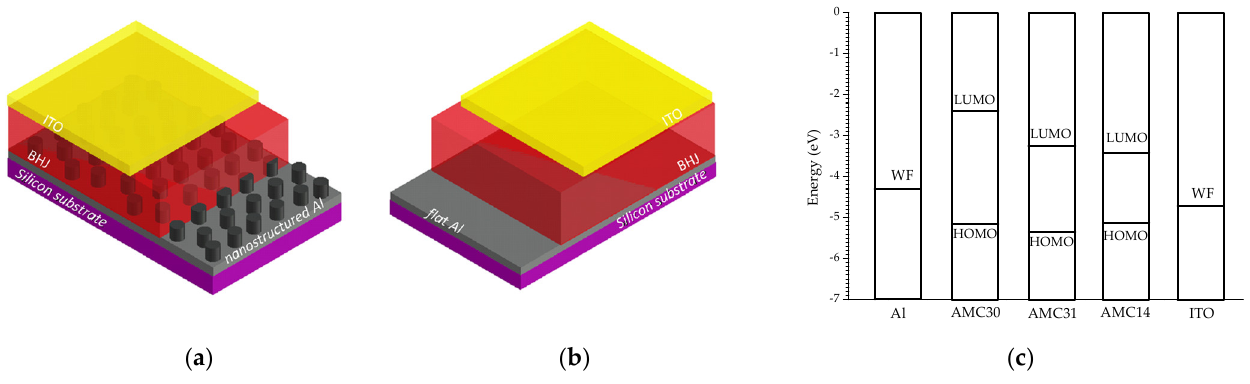
Figure 3. Schematic representation of the organic heterostructure with mixed layer AMC30/AMC31:PCBB/AMC14 on: Al nano electrode ( a ); Al flat electrode ( b ). Energy level diagram with the position of the HOMO, LUMO and work function (WF) level for the components of the heterostructures ( c ).